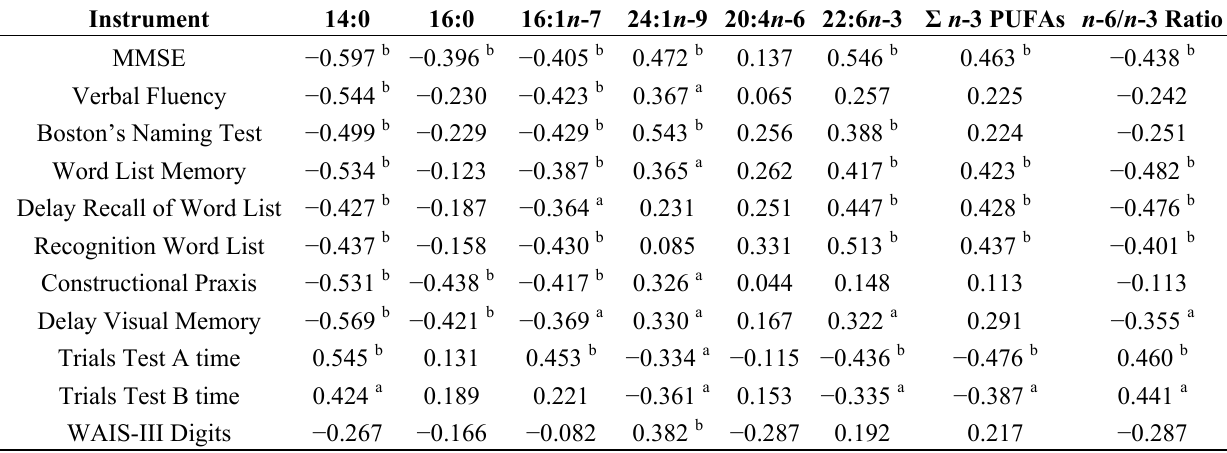
Table 4. Correlation coefficients ( r ) between cognitive performance (different applied instruments) and fatty acids ( n =